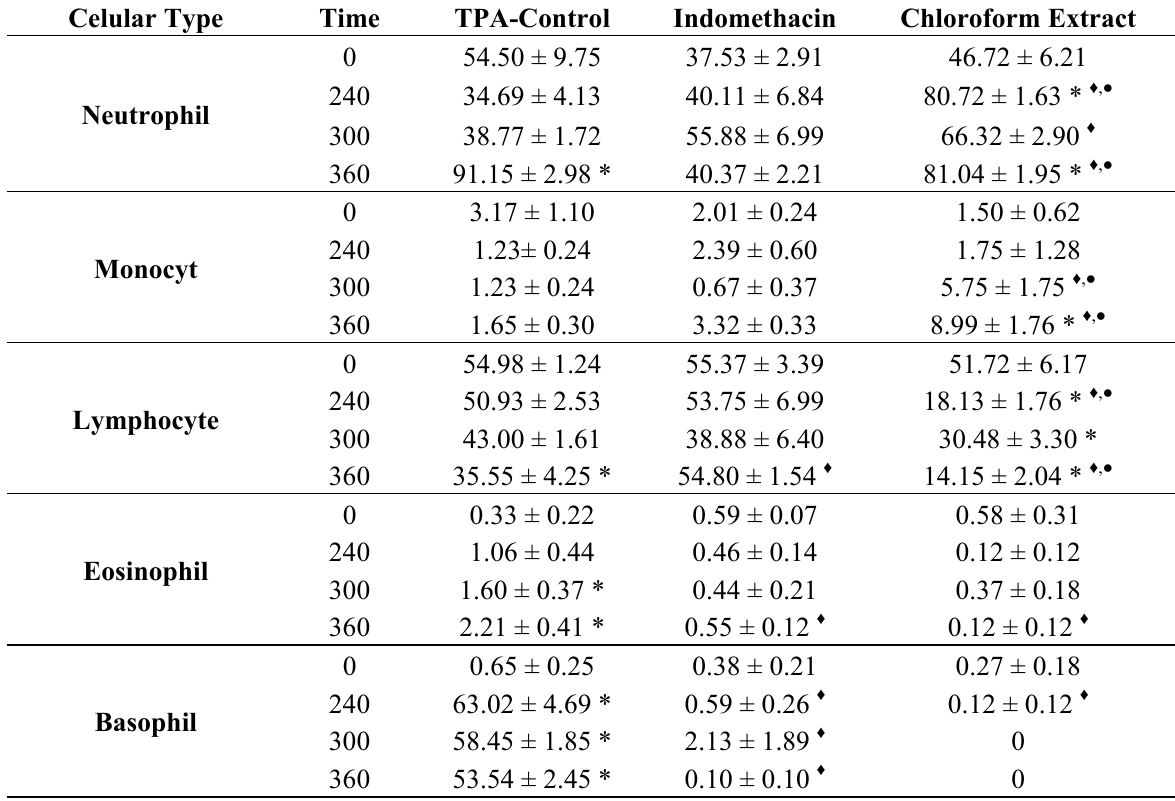
Table 2. Temporal curse of the leukocyte differential count in the model of TPA-induced ear